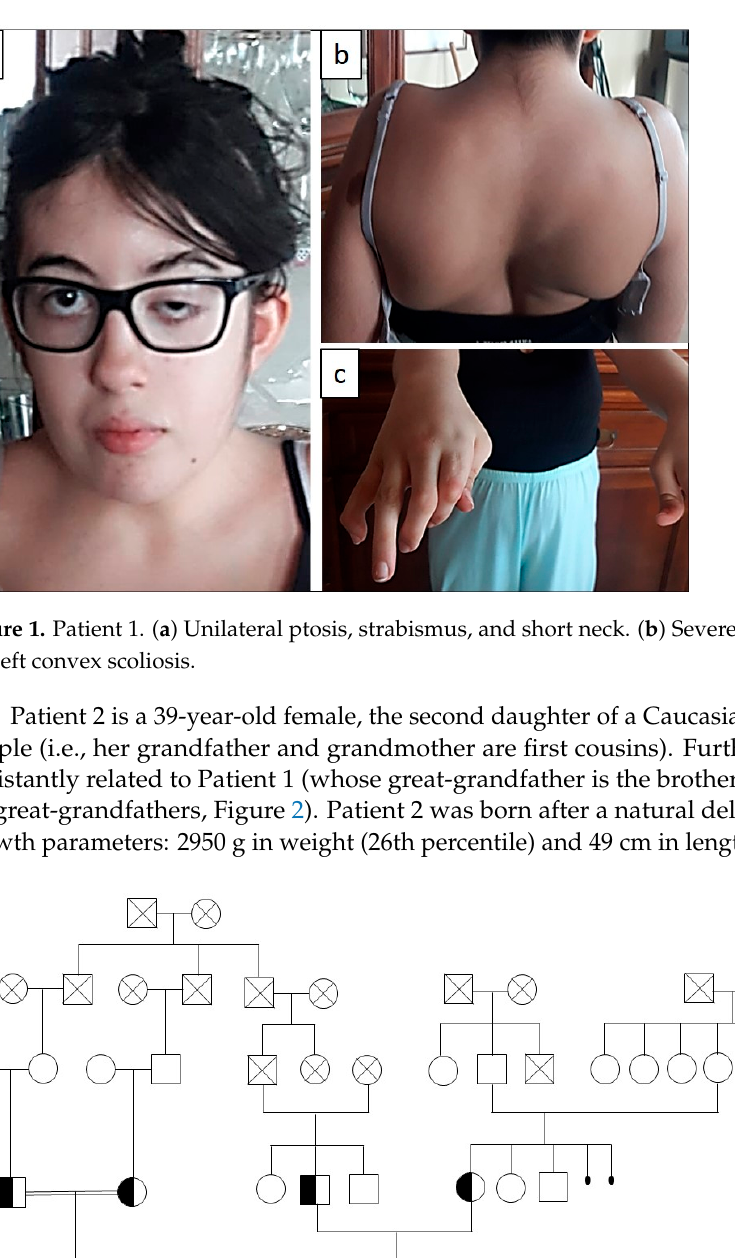
Figure 2. Family pedigree of patients.